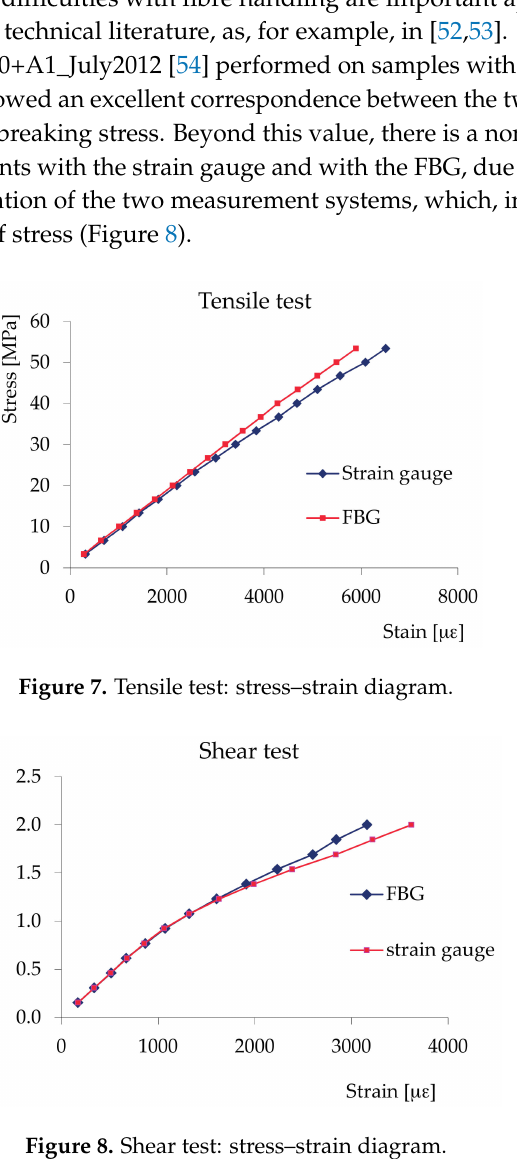
Figure 8. Shear test: stress–strain